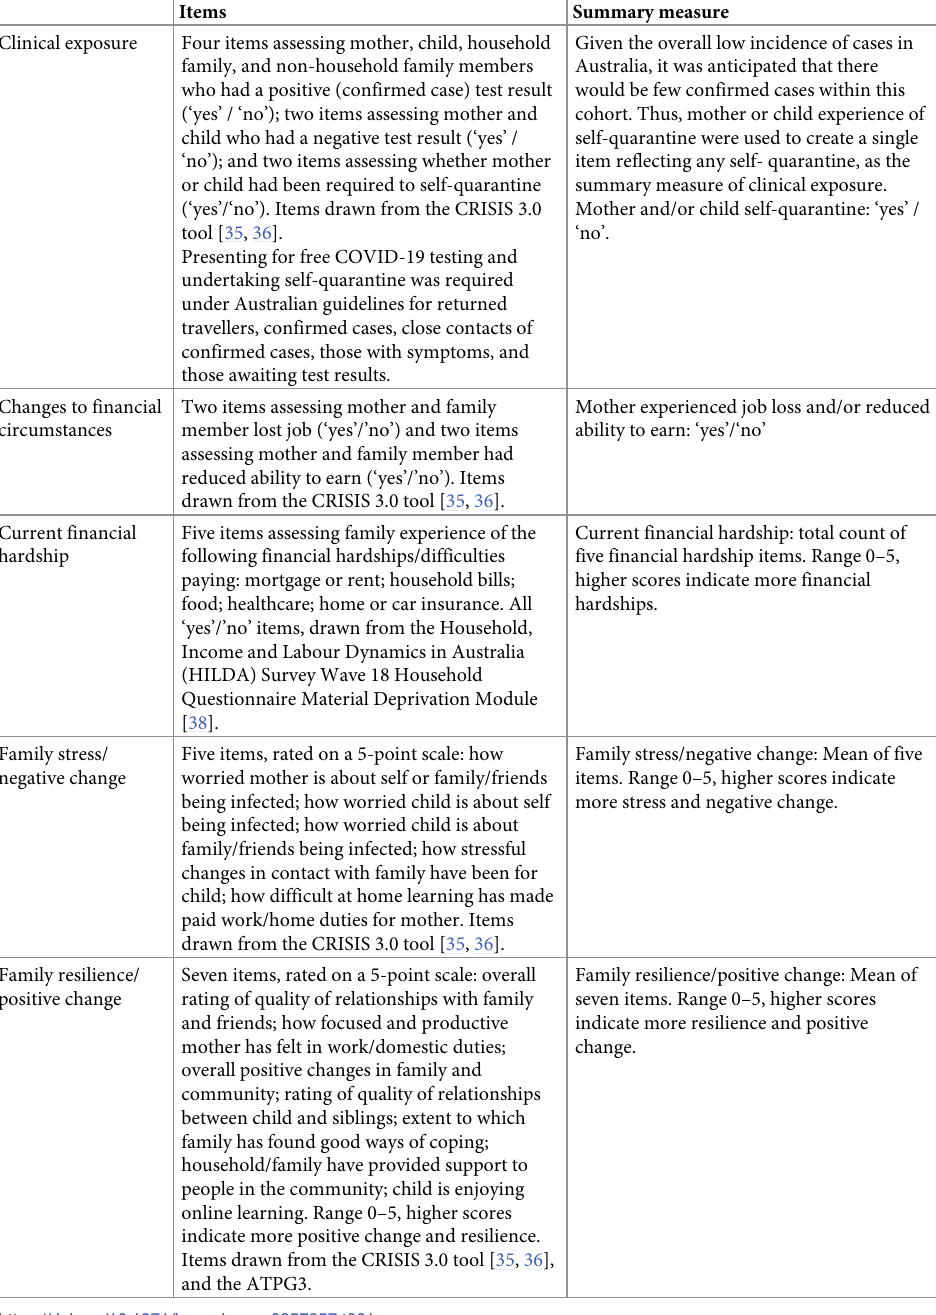
Table 1. Measures of families’ experiences during the COVID-19 pandemic and public health restrictions (COVID-19 impacts).